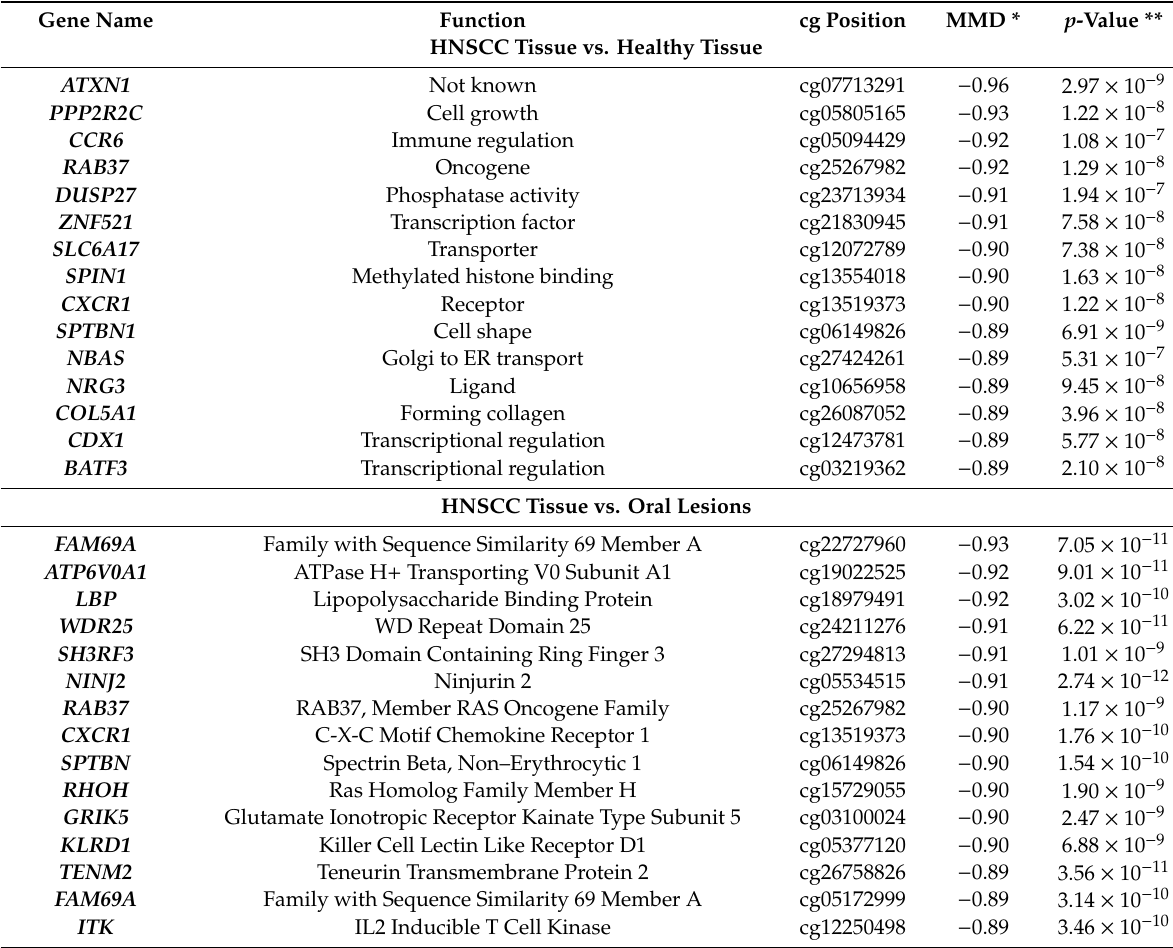
Table 4. Hypomethylated CpG sites methylation in HNSCC tissue compared to control healthy tissue and potentially premalignant oral lesions, and in potentially premalignant oral lesions compared to control healthy tissue. The list is merged of top fifteen di ff erentially methylated genes according to the extent of methylation di ff erence